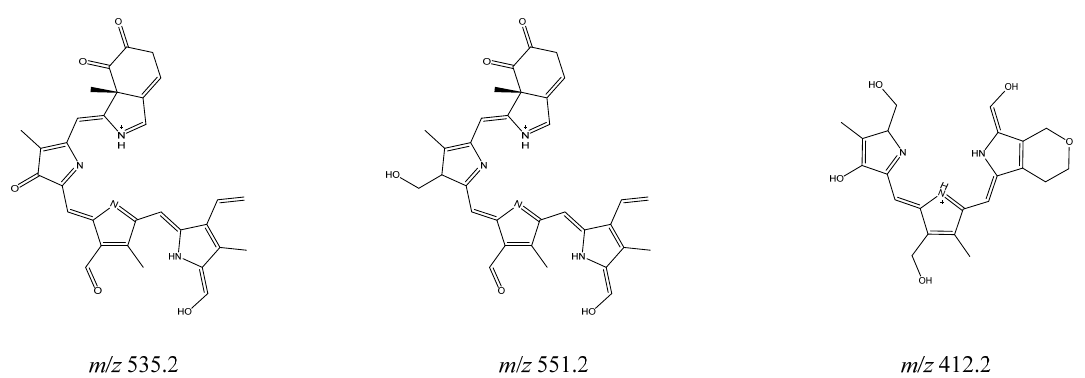
Figure 6. Proposed structures of the photofragments observed following solution photolysis. The fragment m / z 412.2 structure is proposed to attach a H atom to become the m / z 413.2 ion observed upon ESI. (The lowest energy position for this H atom to attach to form the observed m m / z 413.2 is unclear.)